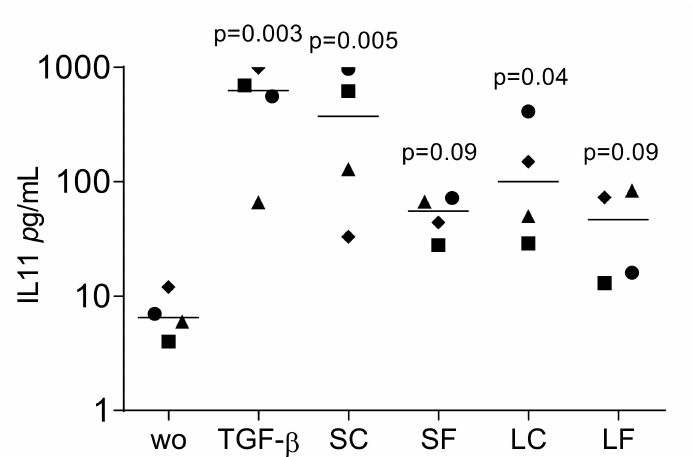
Figure 3. IL11 levels in the culture medium of fibroblasts exposed to supernatants and acid lysates of allografts. Gingival fibroblasts were exposed to aqueous supernatants of OraGRAFT ® Demineralized Cortical Particulate (SC) and OraGRAFT ® Prime (SF) and the acid lysates of the two respective allografts (LC and LF). The IL11 levels were measured by immunoassay. N = 4. Statistic is an uncorrected Friedmann test against untreated